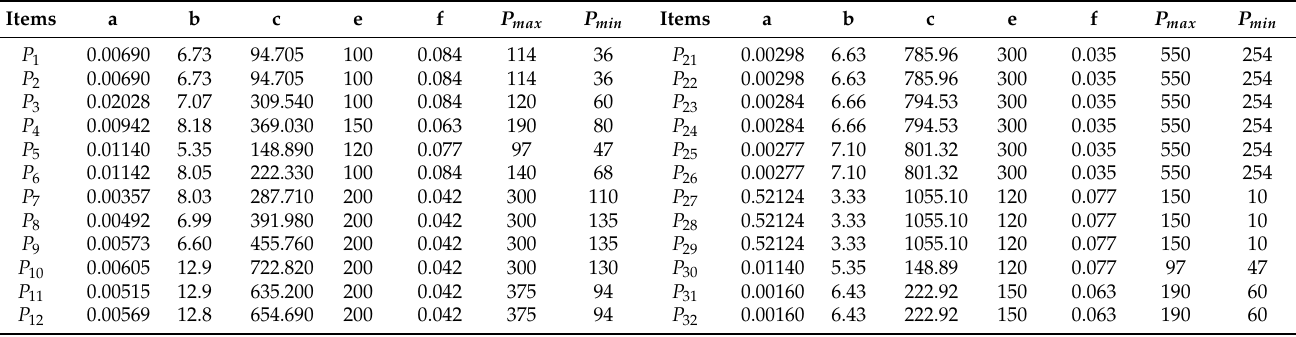
Table A3. Cost coefficients and unit characteristics of Case